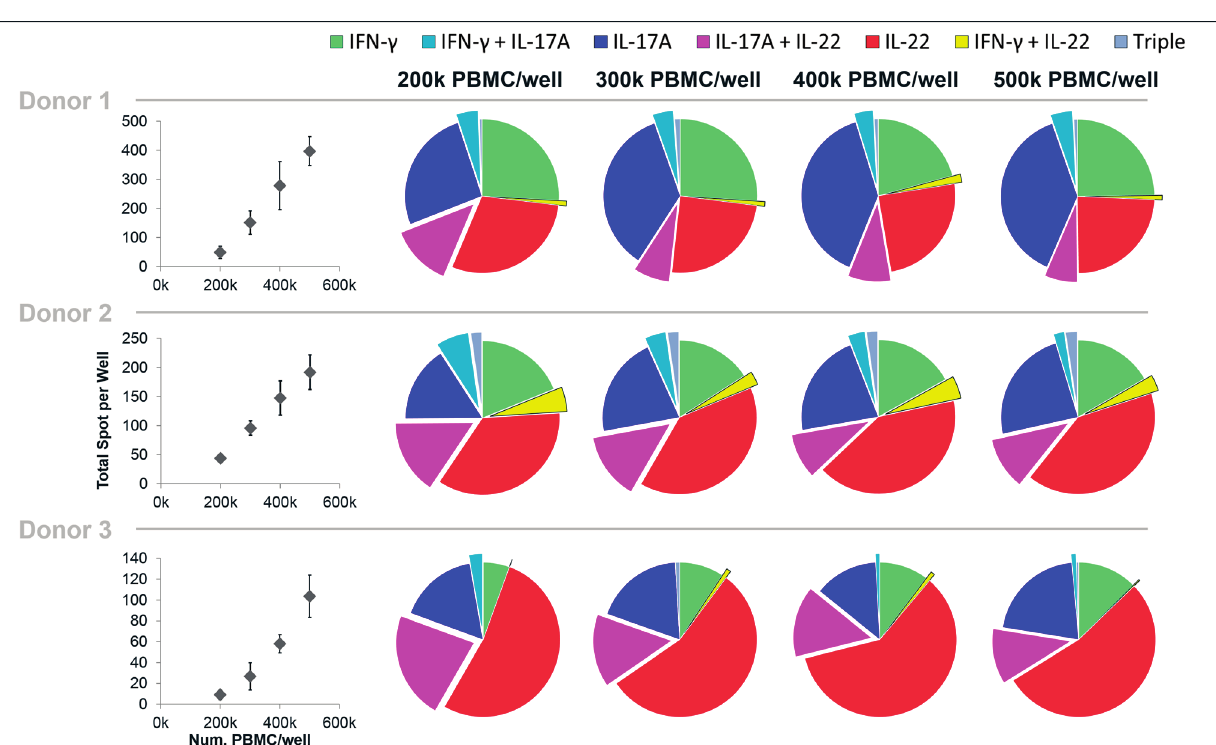
Figure 4. Linearity of PBMC responses to CA, analyzed by IFN- γ /IL-17A/IL-22 triple FluoroSpot. PBMC from three donors were incubated with stimuli or medium alone and analyzed for spots representing cells secreting single-, double- and triple combinations of IFN- γ , IL-17A and IL-22. Quadruplicate wells with 200,000, 300,000, 400,000 or 500,000 PBMC/well were analyzed. The graphs to the left show the mean total number of spots/well and standard deviation obtained for each cell concentration. The charts to the right show the proportion of single-, double- and triple spots for each cytokine/cytokine combination per total number of